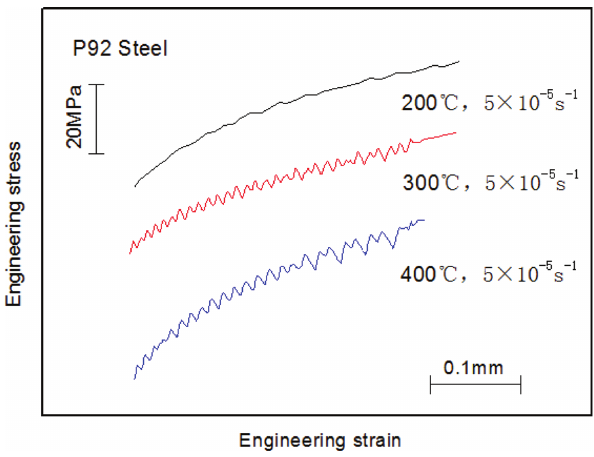
Figure 2: Segments of engineering stress – strain curves of P92 steel obtained from tensile tests at three different temperatures at the strain rate of 5 × 10 − 5 s − 1 .